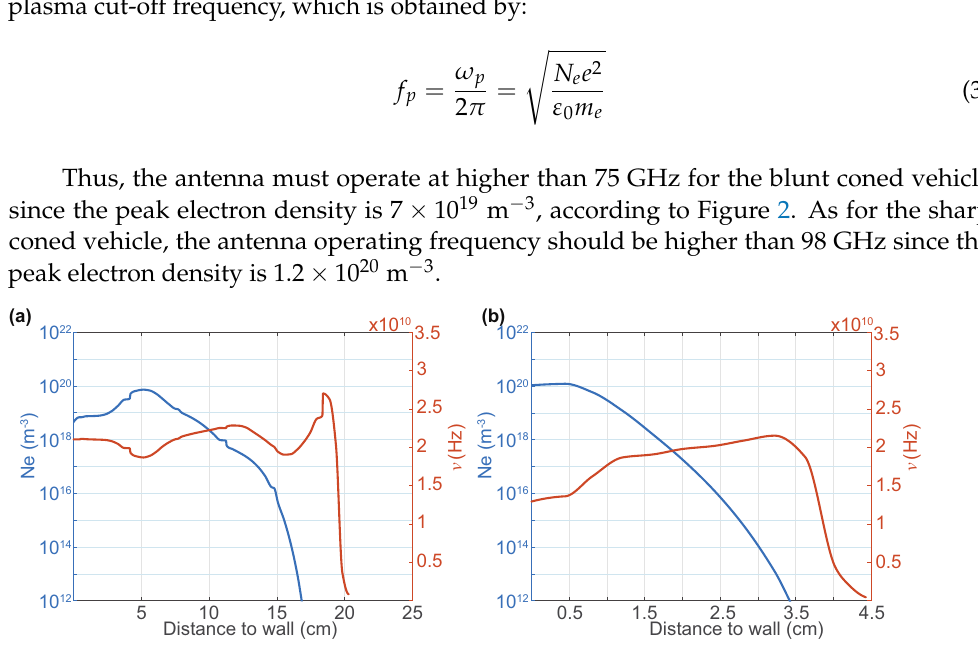
Figure 2. ( a ): The electron density distribution and electron collision frequency distribution for the blunt-coned vehicle along the propagation path (the gray arrow in Figure 1a,c). ( b ): The electron density distribution and electron collision frequency distribution for the sharp-coned vehicle along the propagation path (the gray arrow in Figure